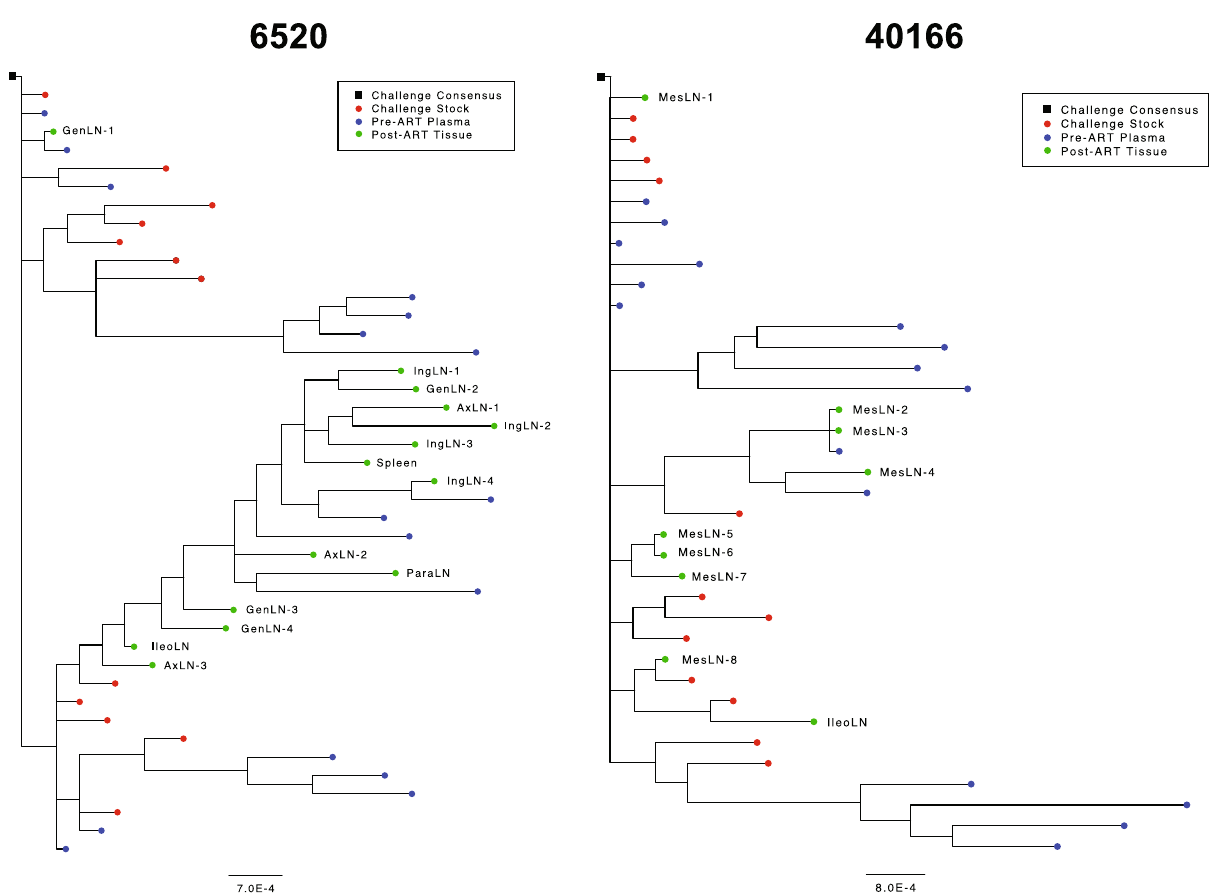
Fig. 7 Phylogenetic analysis of the gag-pol sequences of macaque 6520 and 40166. Gag-pol sequences from SIVmac251 infected animals 6520 (Late ART cohort) and 40166 (Early ART cohort) isolated by single genome ampli fi cation (SGA). Viral sequences were sampled at challenge (in red), were derived from pre-ART plasma (in blue), and from lymph nodes at necropsy during ART suppression (in green). The root of each tree is the consensus challenge stock (black square). Branch length distance de fi ned as number of mutations per base. MesLN, mesenteric LN, GenLN, genital LN, IngLN, inguinal LN, AxLN, axillary LN, ParaLN, pararectal LN.